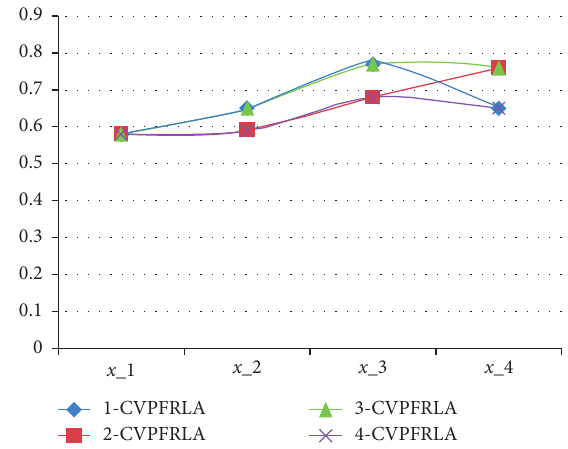
Figure 1: The presentation of lower approximations by using our models and the previous model.